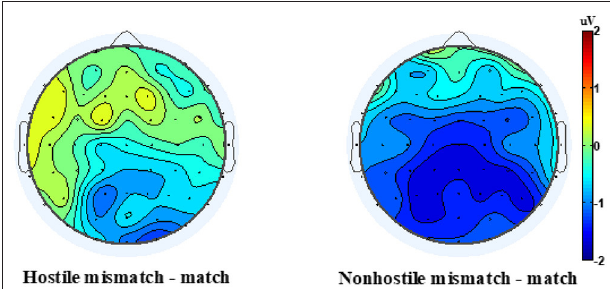
FIGURE 3 | Topographic maps of mean ERP differences waveforms (ERP mismatch minus ERP match) for the violation of non-hostile intention expectency (hostile mismatch – match) and the violation of hostile intention expectency (non-hostile mismatch – match) conditions for the 450–650ms post critical word time